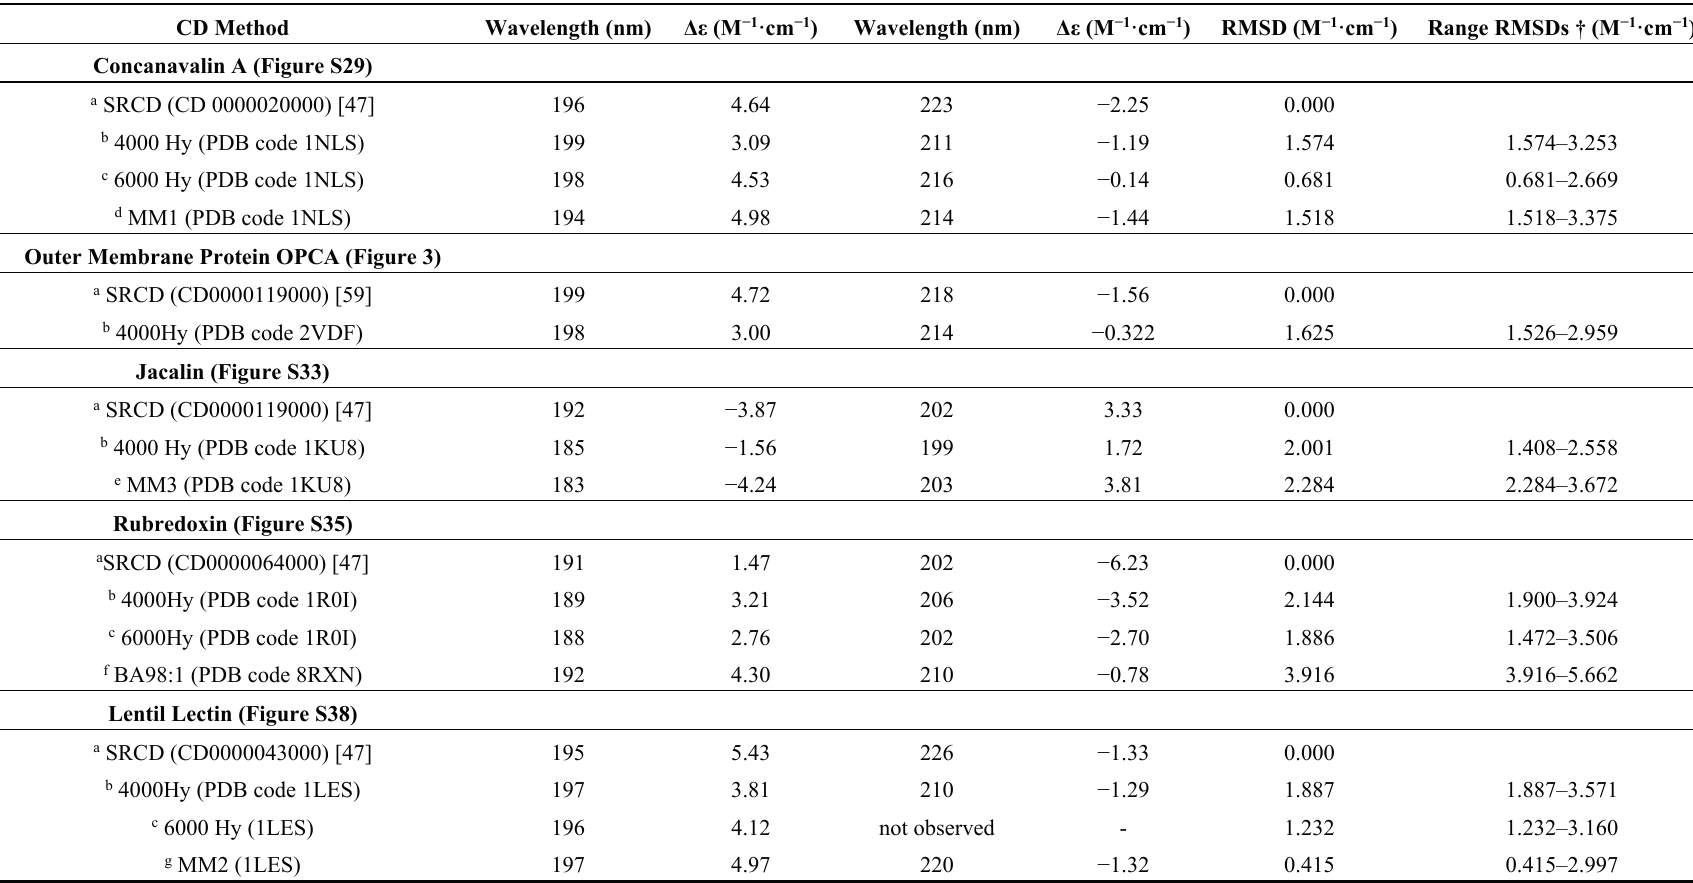
Table 2. CD Analysis of β -Sheet Proteins. All RMSDs are calculated between 180 and 210